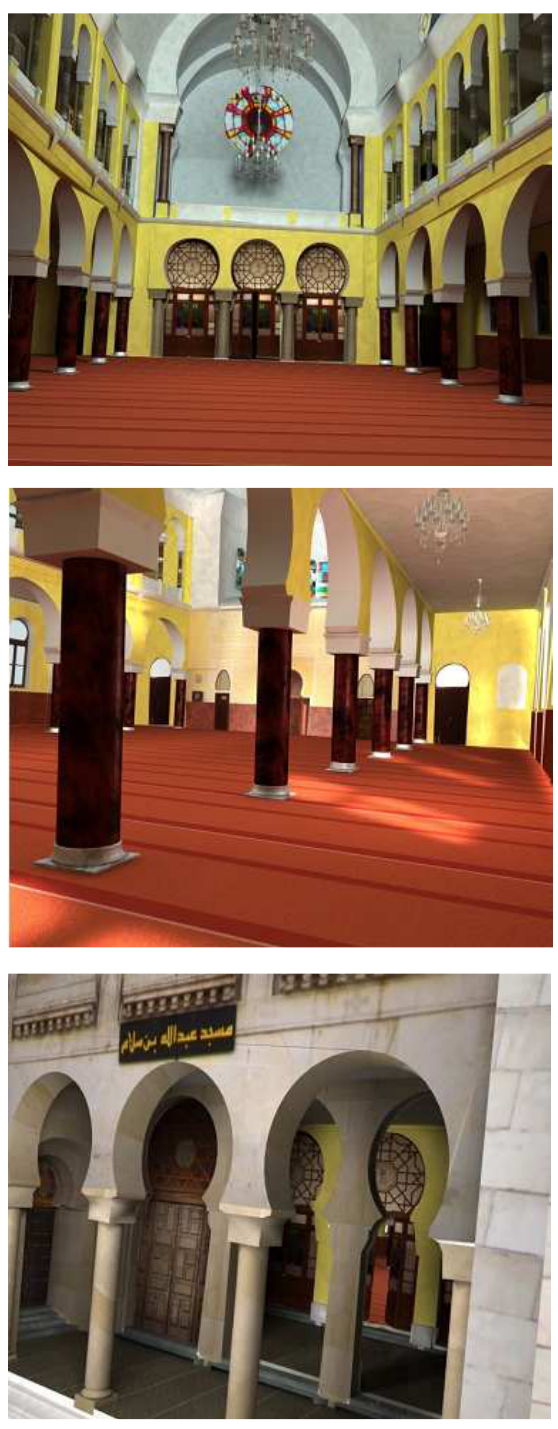
Figure 15. Example of the final photorealistic 3D